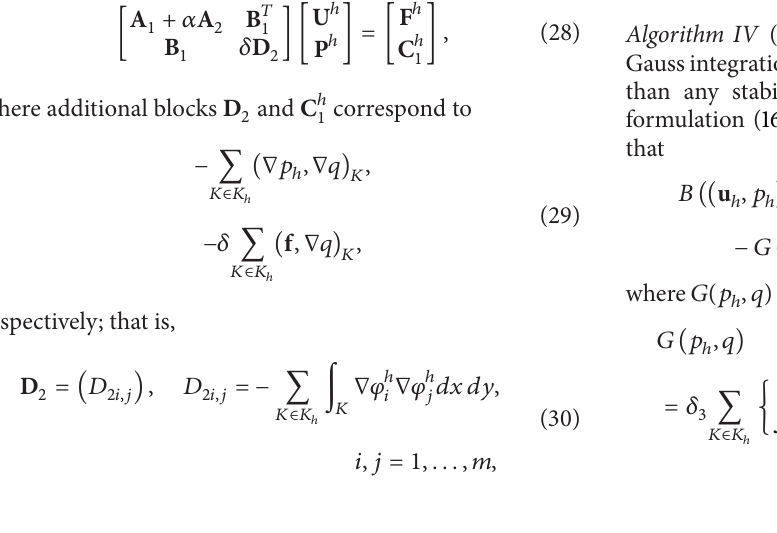
Algorithm IV (Local Gauss integration method). The